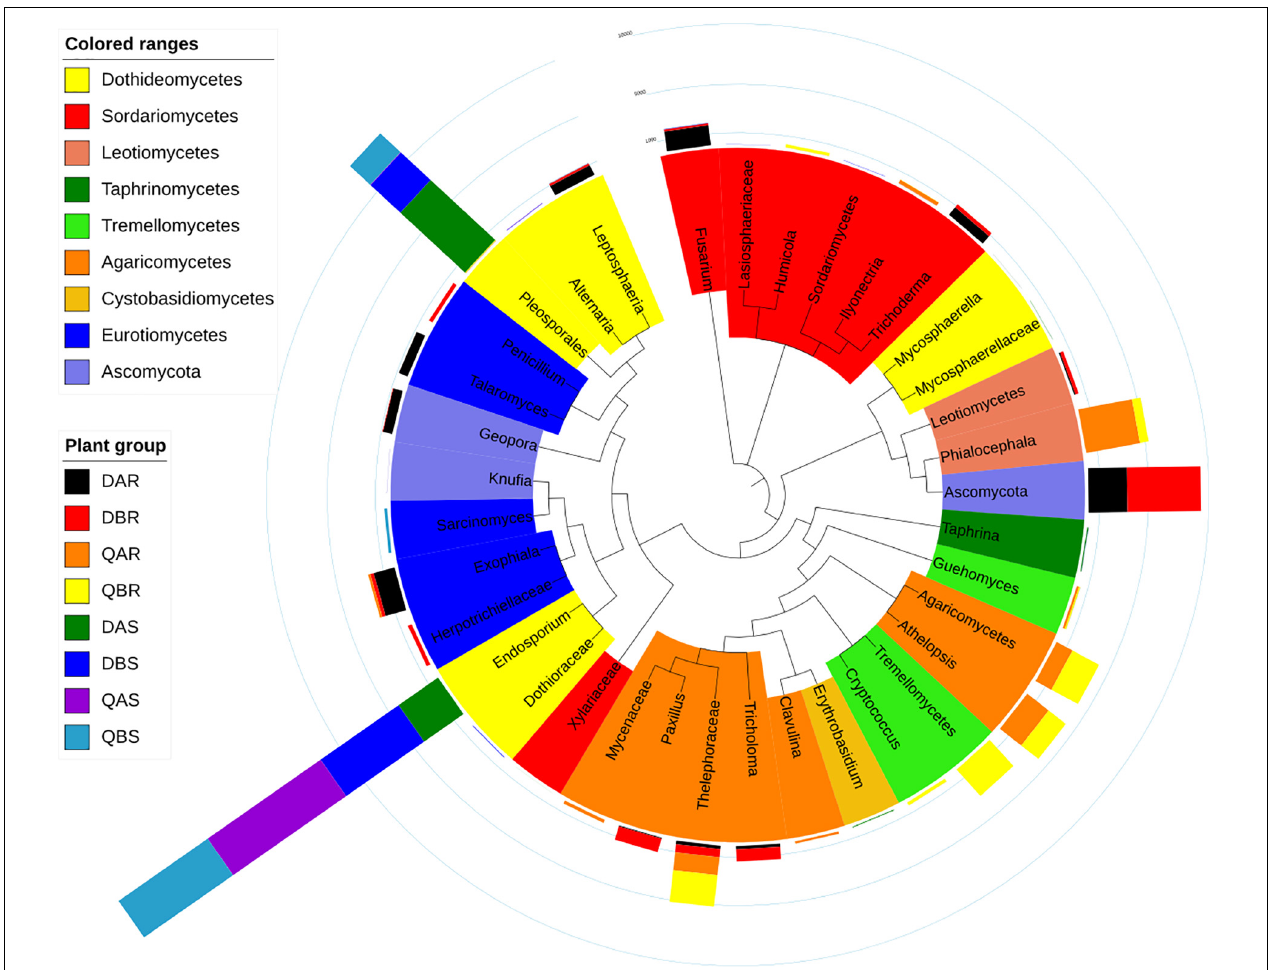
FIGURE 7 | Top operational taxonomic units (OTU) members of the fungal microbiome. A taxonomic dendrogram showing the core fungal microbiome of each plant group. Color ranges identify classes within the tree. Colored bars represent the relative abundance of each OTU in each plant group. The taxonomic dendrogram was generated with one representative sequence of each OTU using FastTree and displayed using iTOL (Interactive Tree Of Life). The total relative abundances of all OTUs and the significant effects across plant compartments are listed in Supplementary Table S9 .